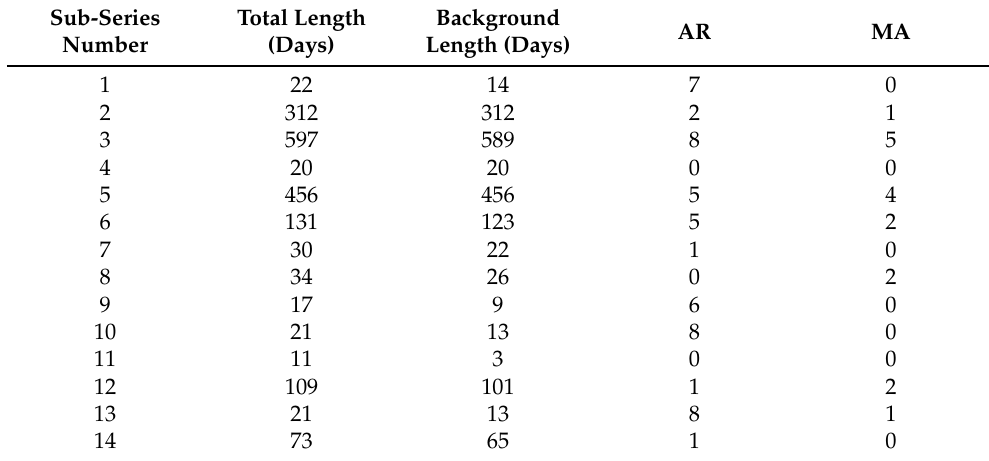
Table 2. Details of the ARFIMA best model evaluated for each sub-series. The last two columns report the order of the AutoRegressive (AR) and Moving Average (MA)